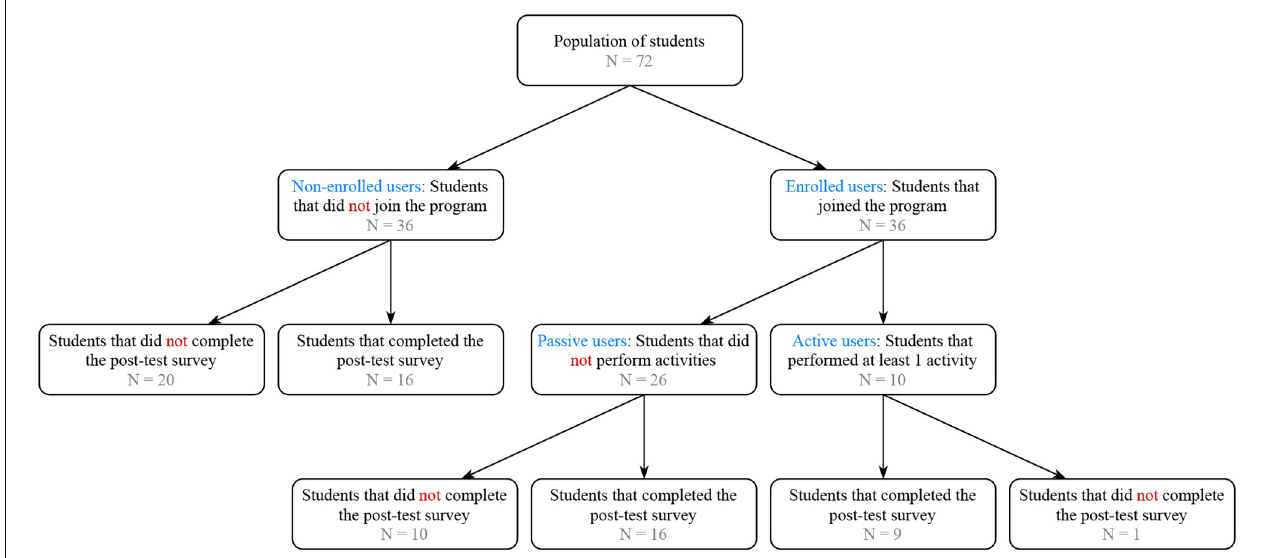
FIGURE 2 | Cohort diagram that details the number of students enrolled in different study phases.